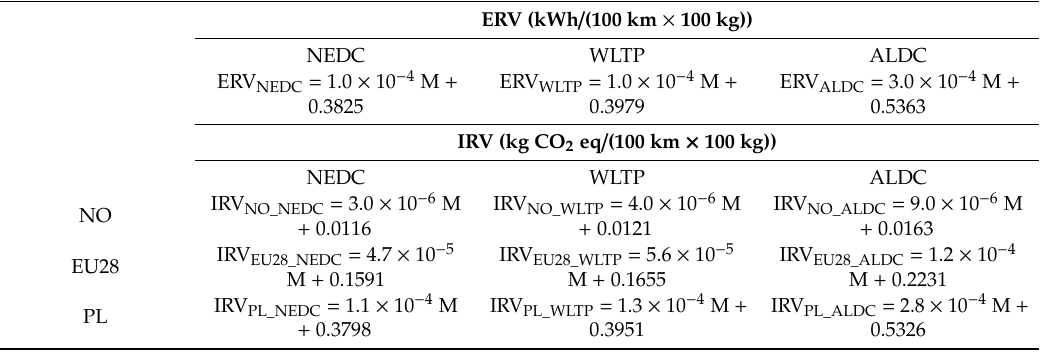
Figure 8. IRV for all case studies in function of vehicle mass: regression lines. Table 3. Modeling of ERV/IRV: equations of regression lines in function of mass.